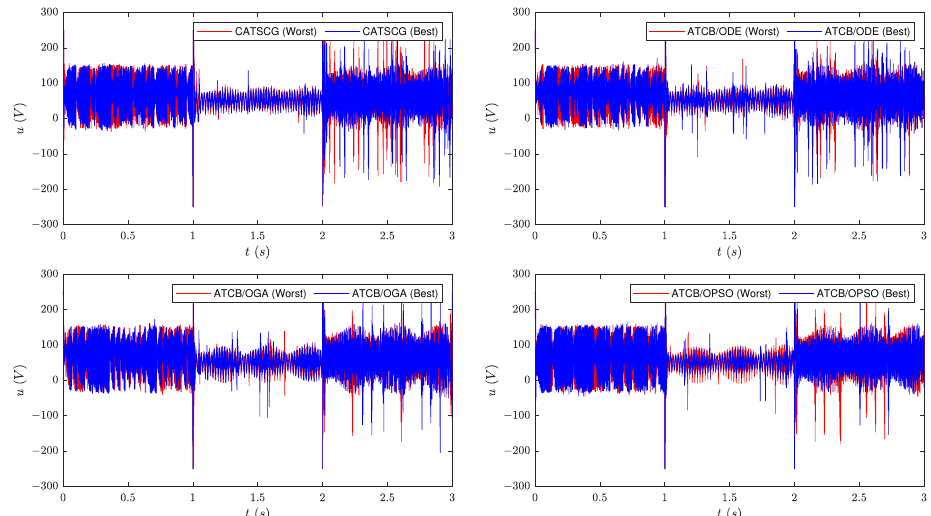
Figure 8. Control action for the best and worst runs of the adaptive controller tuning, consider- ing NOC.